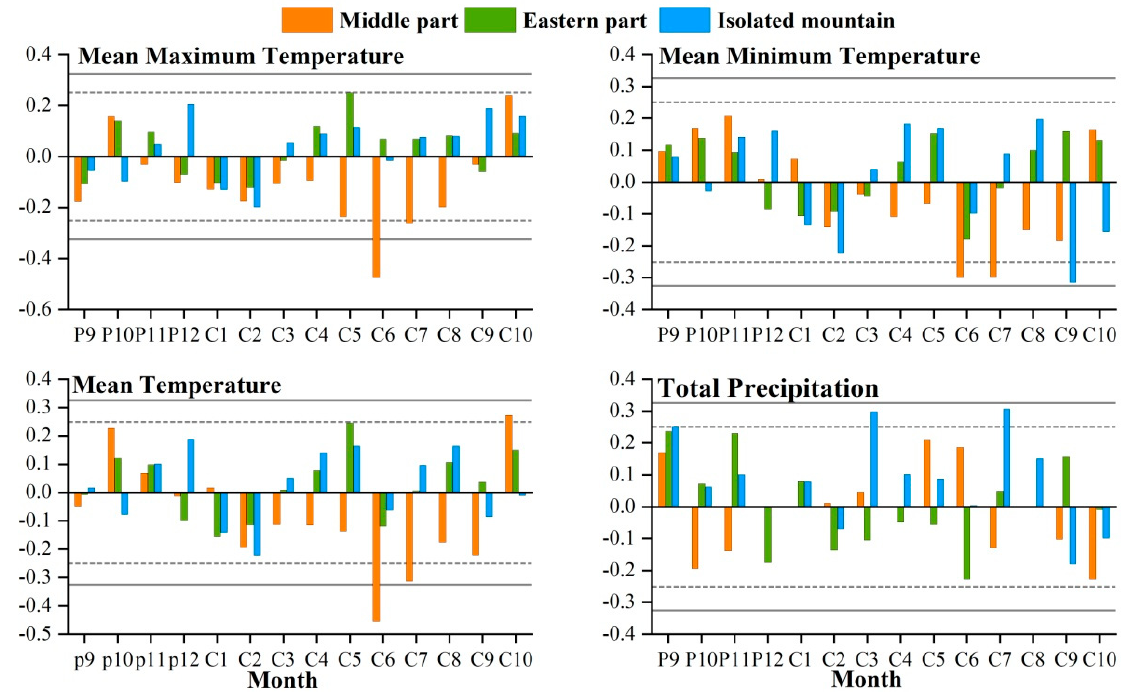
Figure 5. Correlations between tree-ring width chronologies and climatic factors in the three Central and Eastern Qilian Mountain regions.